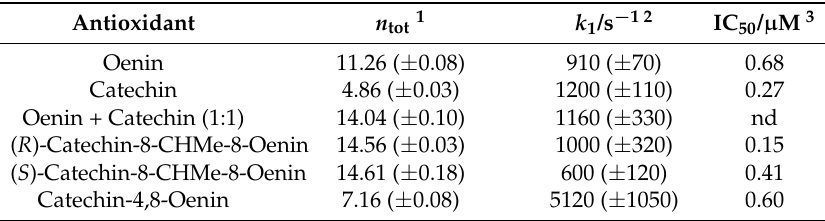
Table 1. Antioxidant activity of malvidin 3- O -β- D -glucoside (oenin) and related pigments: reduction of the DPPH (2,2-diphenyl-1-picrylhydrazyl) radical (MeOH, 25 °C, 1 and 2 ) and inhibition of heme- induced peroxidation of linoleic acid (0.1 mM linoleic acid in acetate buffer + 2 mM Tween-20, 0.1 µM metmyoglobin, pH = 4, 37 °C, 3 ). From reference [29].